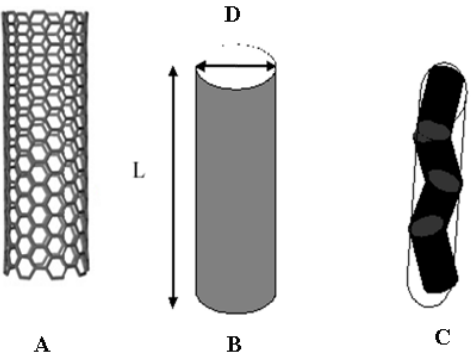
Figure 1. ( A ) Schematic picture of SWCNTs; ( B ) major axis length, L , and diameter, D , from which axial ratios are determined. In ( C ) is reported a scheme indicating the case when kinks are